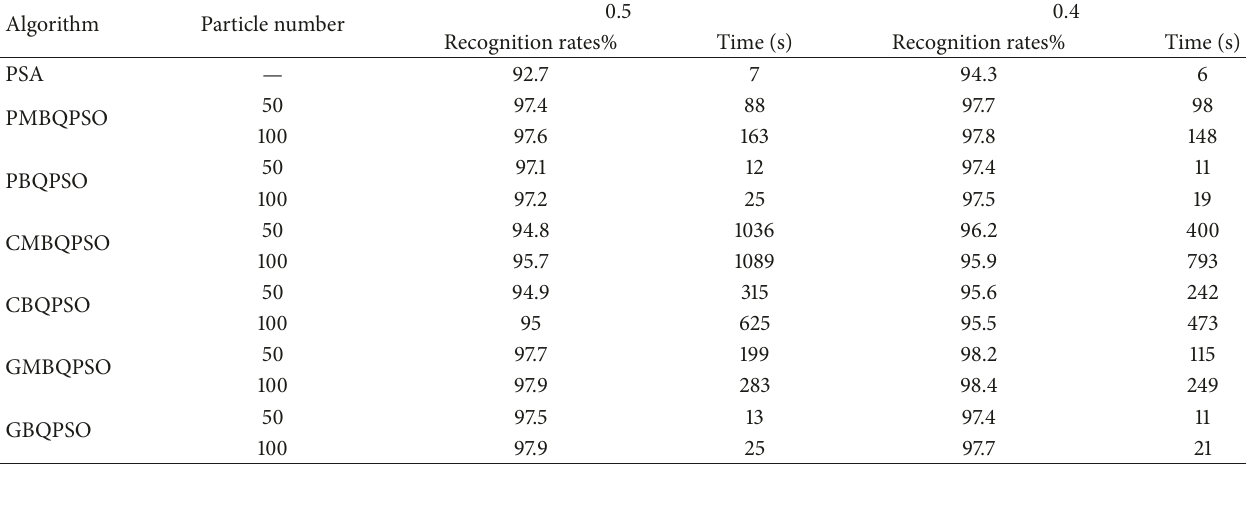
Table 6: PaviaU subimage subpixel mapping results.